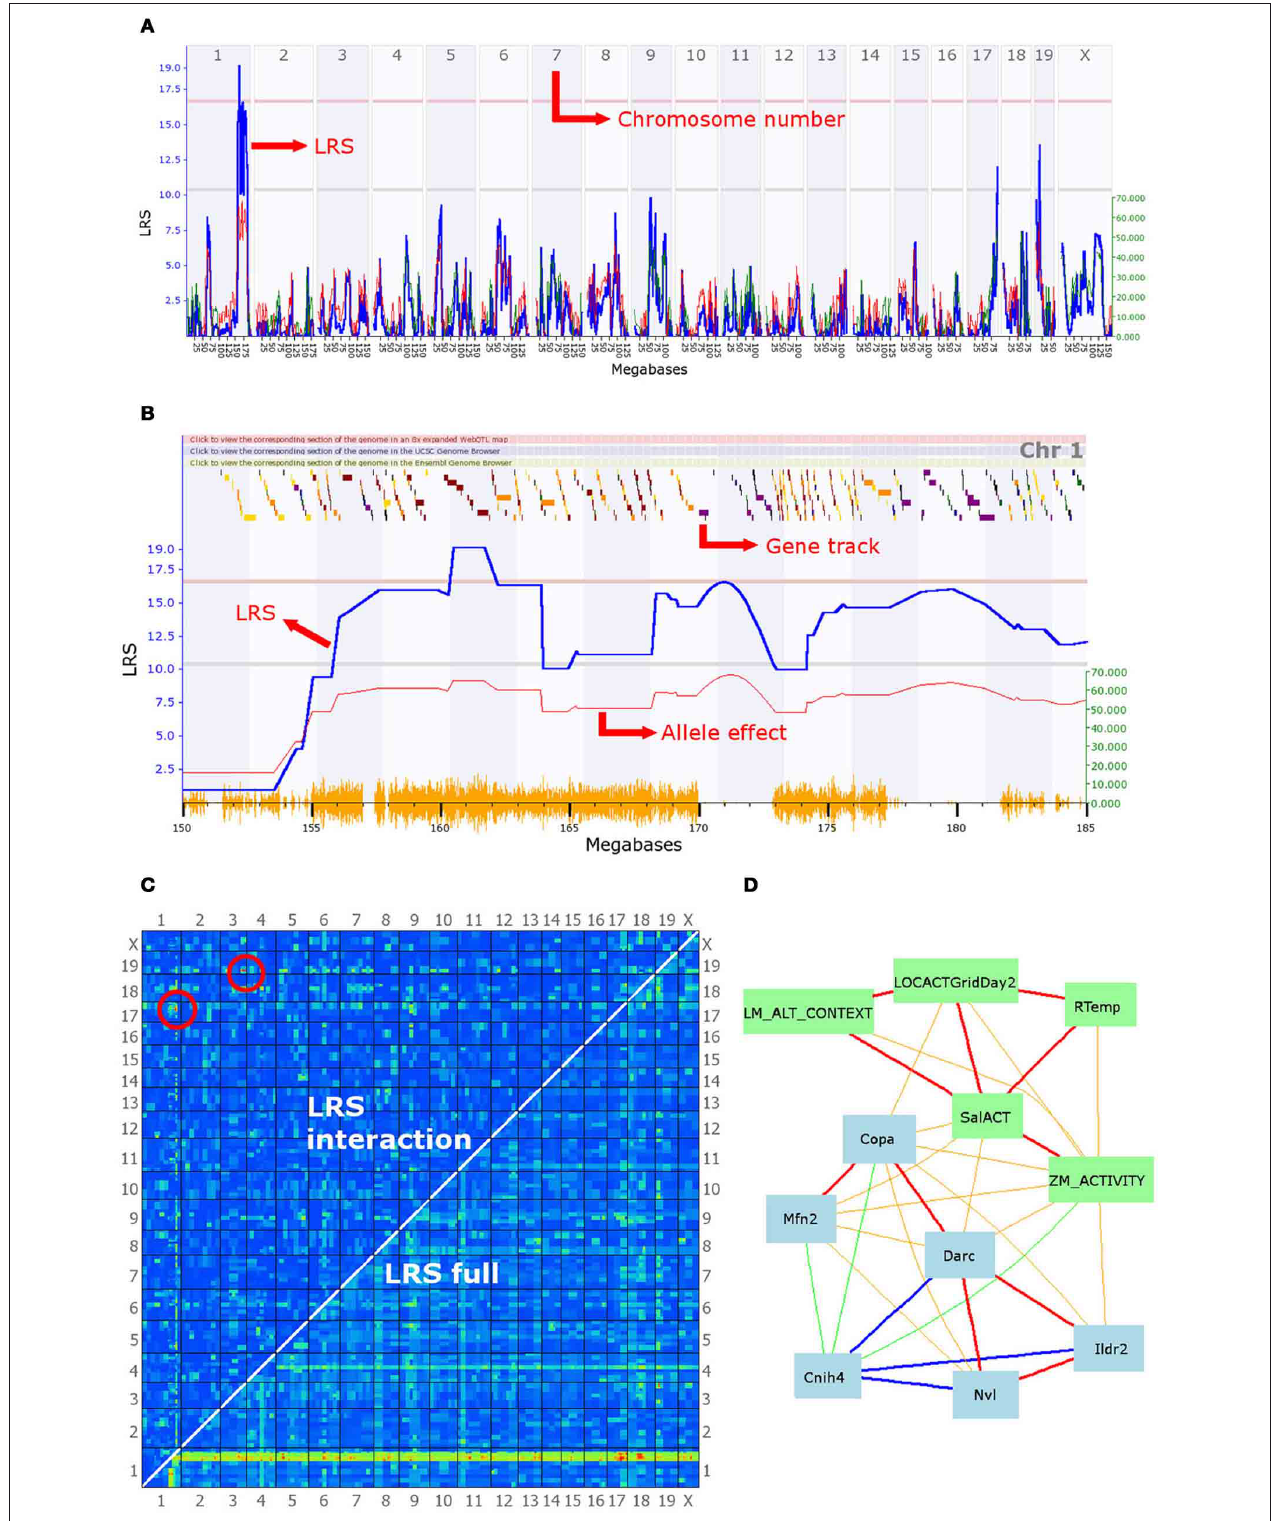
FIGURE 2 | A selection of the analytical tools available on GeneNetwork. In this example, the focal trait (ID number 12361) is a behavioral phenotype (mouse activity in a maze) submitted by Cook et al. and defined as “Anxiety